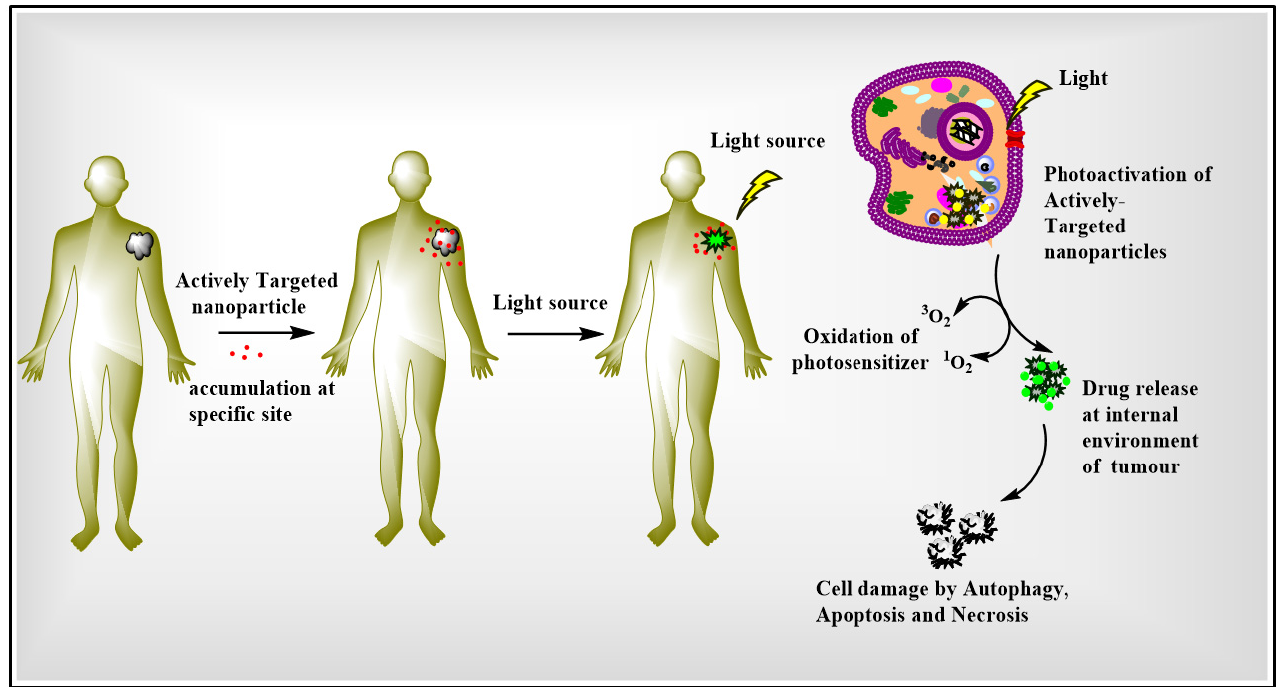
Figure 1. A general application of photodynamic therapy on solid tumors. Once the actively targeted nanoparticles enter the blood circulation, they are transported to the specific site of the tumor. The laser light irradiates the photosensitizer and activates the actively targeted nanoparticles in the tumor. Then, the photosensitizer molecules produce the singlet oxygen to kill the cancer cells by the mechanisms of apoptosis, autophagy, and necrosis, depending on the location of the photosensitizer in the tumor.